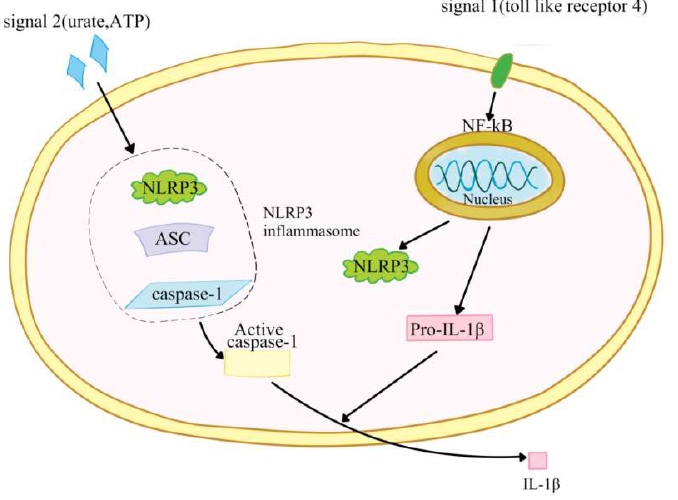
Figure 1. The activation of NRLP3 inflammasome.